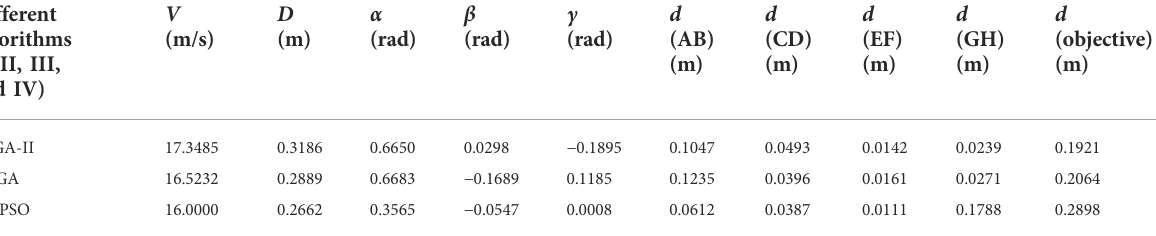
TABLE 4 List of the globaloptimal solution parameters of the group of “ I, II, III and IV ” optimized by different multiobjective optimization algorithms. Different